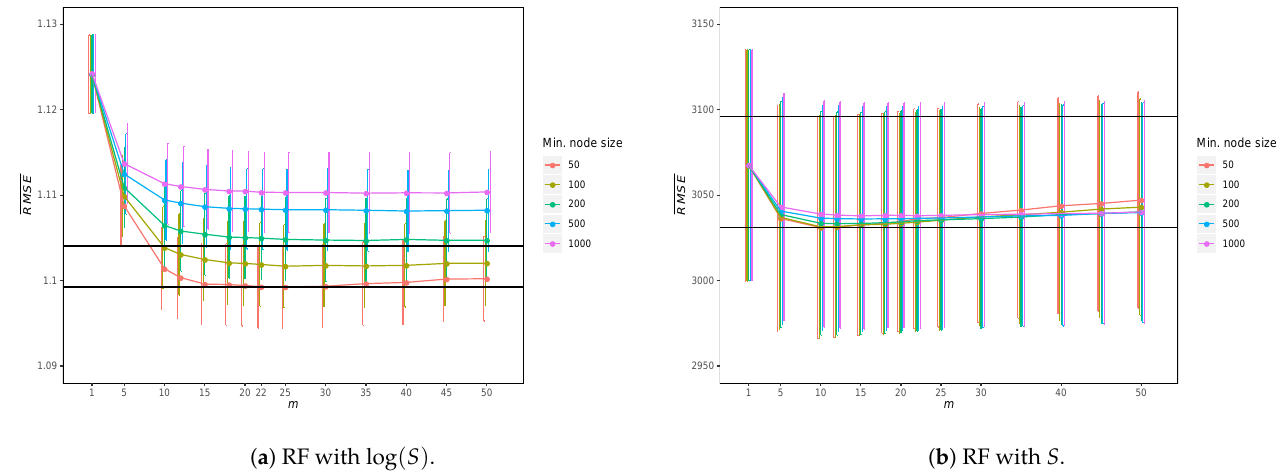
Figure 6. Illustration of the RMSE model error and 95%-confidence intervals for different values of the number of risk factors m and the minimum node size for both RF log S and RF S models.